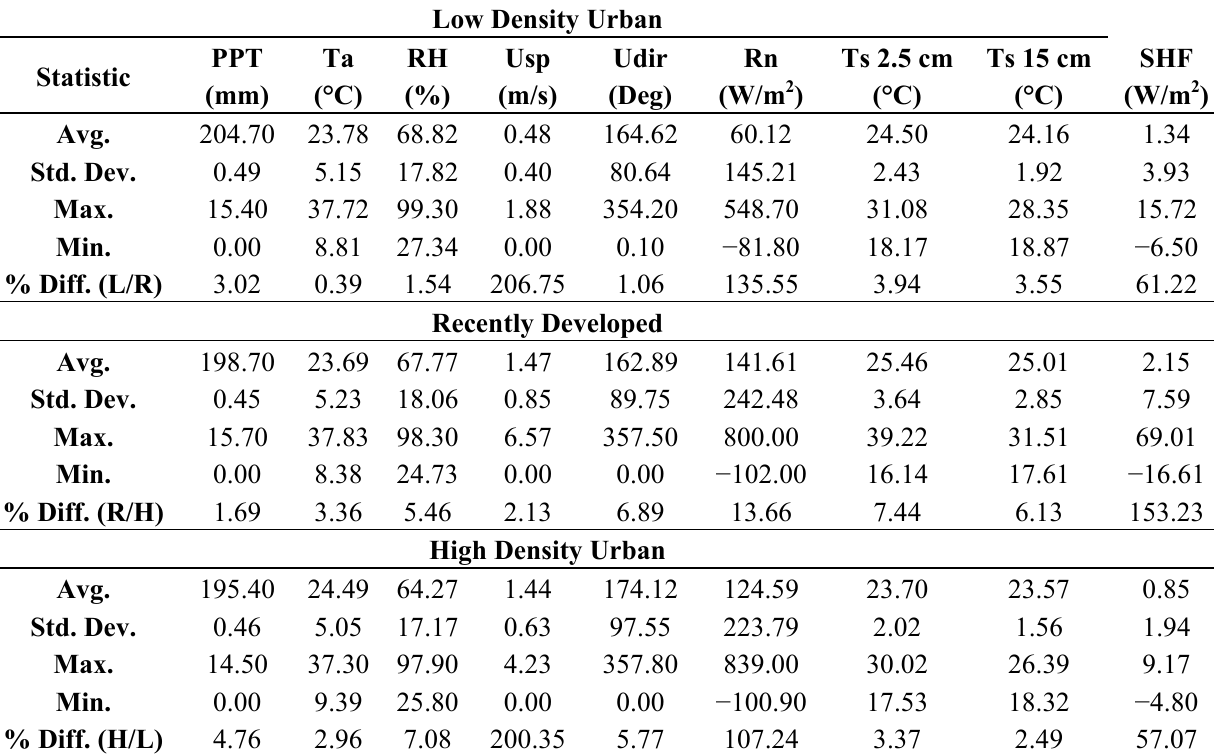
Table 5. Climate results at low density urban, recent development, and high density urban gradient monitoring sites from 2 June 2013 to 28 September 2013, Columbia,